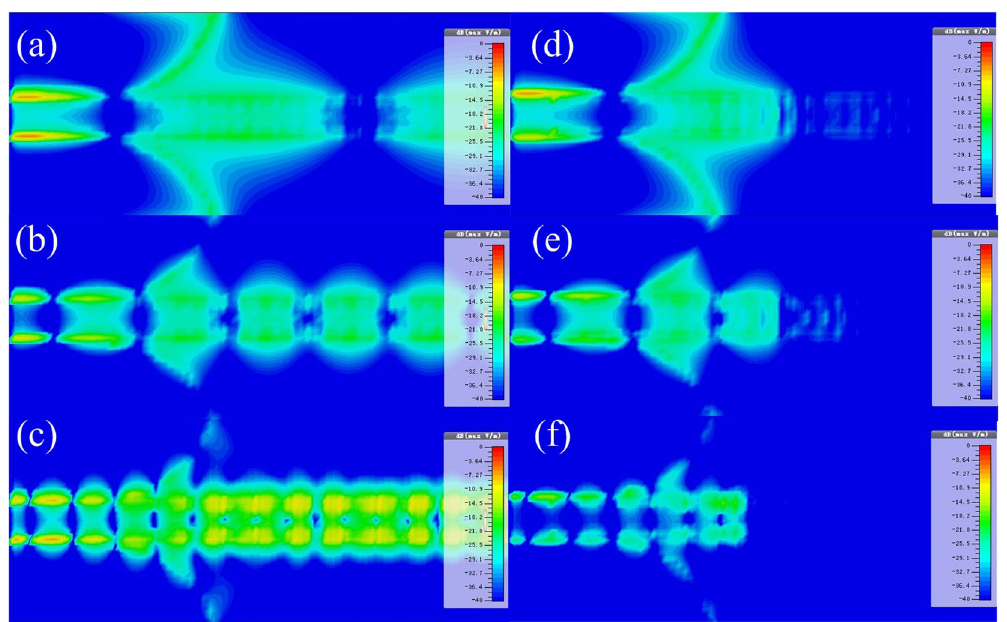
Figure 3. The simulated electric field above the SPP TL and the resistive loaded SPP TL at different frequencies (1 mm above the dielectric substrate). ( a ) 2 GHz (SPP TL). ( b ) 5 GHz (SPP TL). ( c ) 10 GHz (SPP TL). ( d ) 2 GHz (Loaded SPP TL). ( e ) 5 GHz (Loaded SPP TL). ( f ) 10 GHz (Loaded SPP